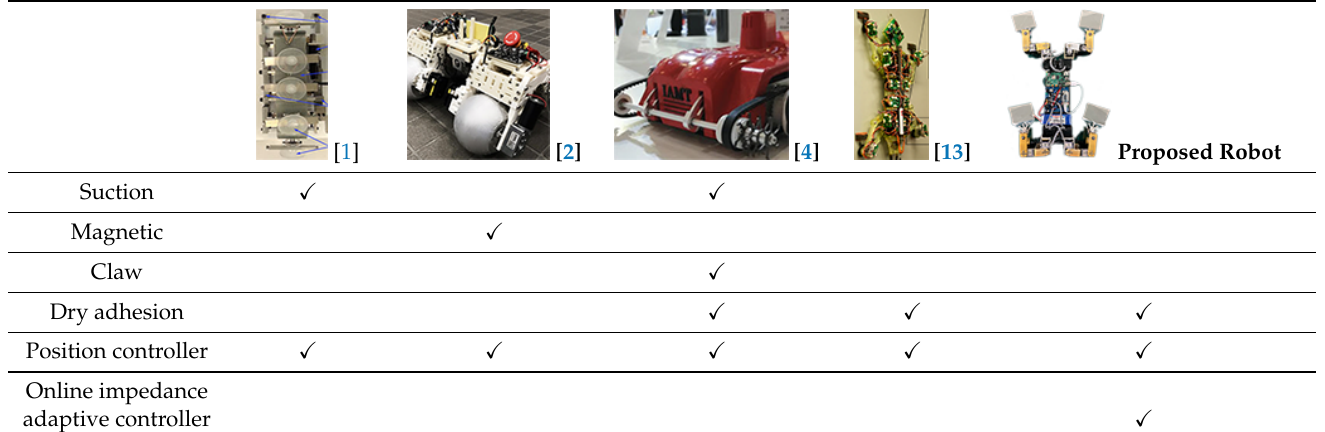
Table 1. Adhesion and motion controller of the existing wall-climbing